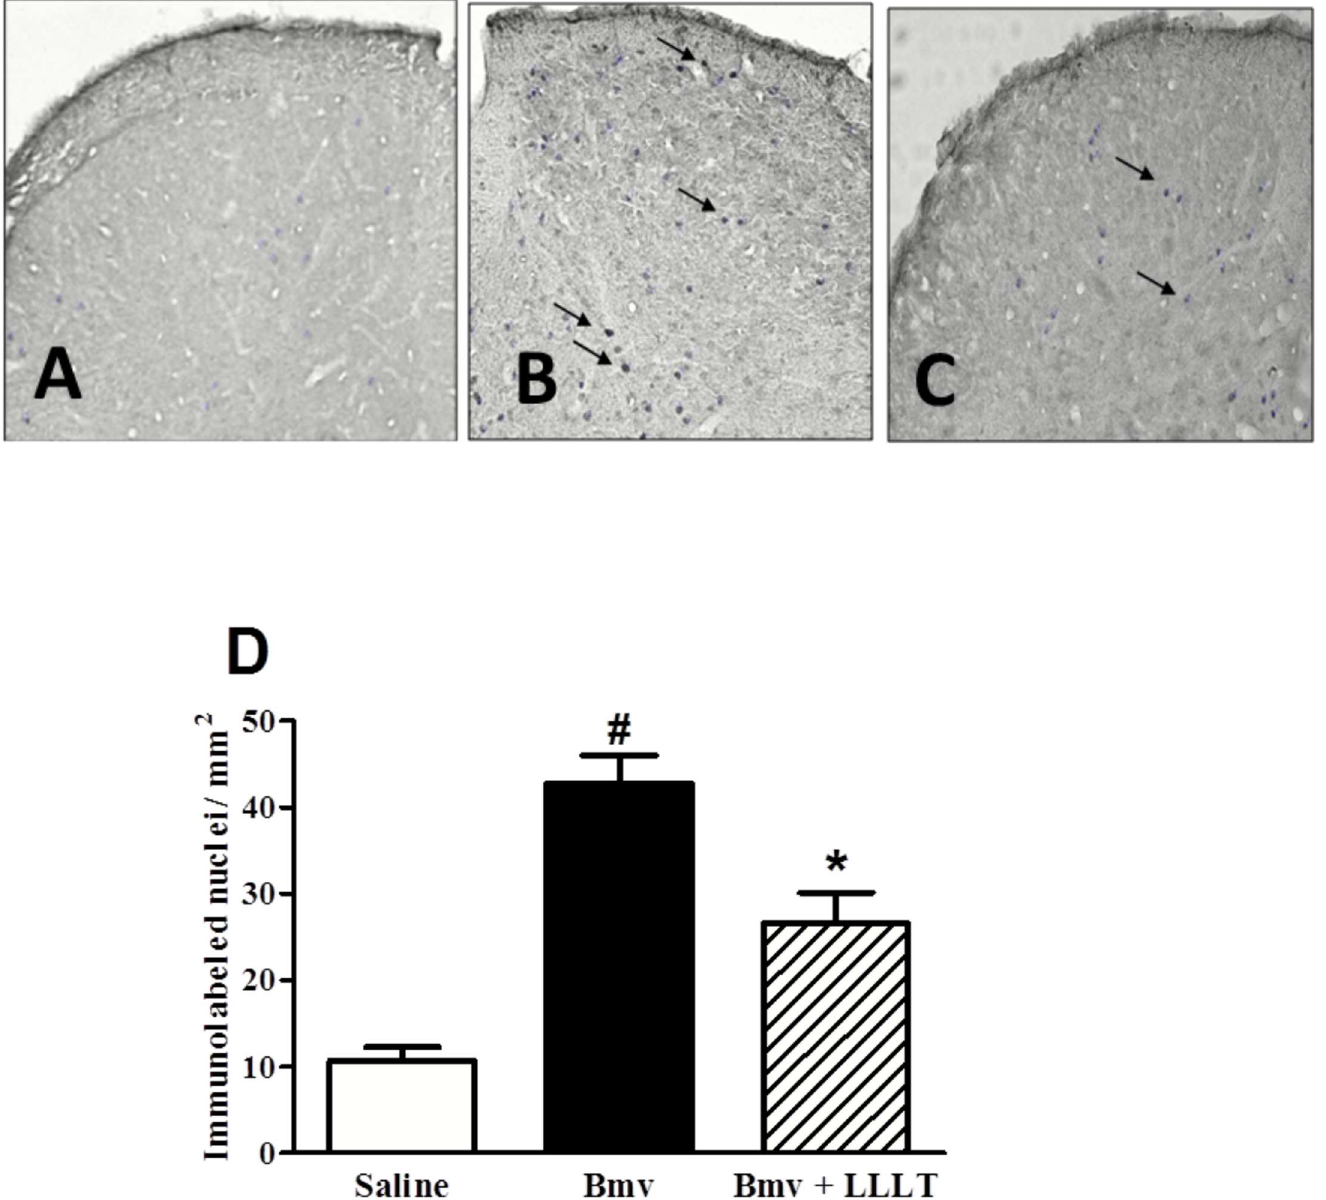
Fig 2. Fos immunolabel in the in the dorsal horn of the spinal cord (DHSC) of mice. Photomicrographs illustrating Fos immunostaining (arrows) in the dorsal horn of the spinal cord (DHSC) of mice injected intraplantarwith saline (A), Bmv (B) or Bmv and laser at 685 nm (C). (D) Mean of the density of nuclei labeledfor Fos protein in the DHSC of mice. Data shows the proto-oncogene immunoreactivity on the right side, ipsilateral to the paw irradiated. Values represent the mean ± SEM of 5 animals for group. Statistically significant differences vs. saline ( # p < 0.05) or vs. BmV ( * p < 0.05) are